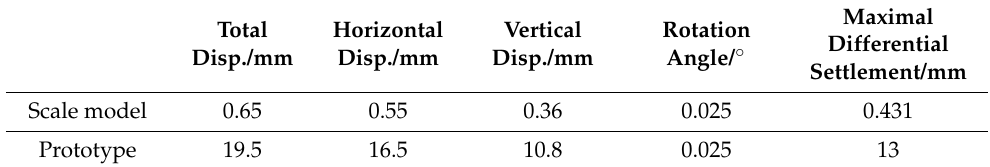
Table 3. Estimation of deformation magnitude of the anchorage structure based on the DEM simulation.